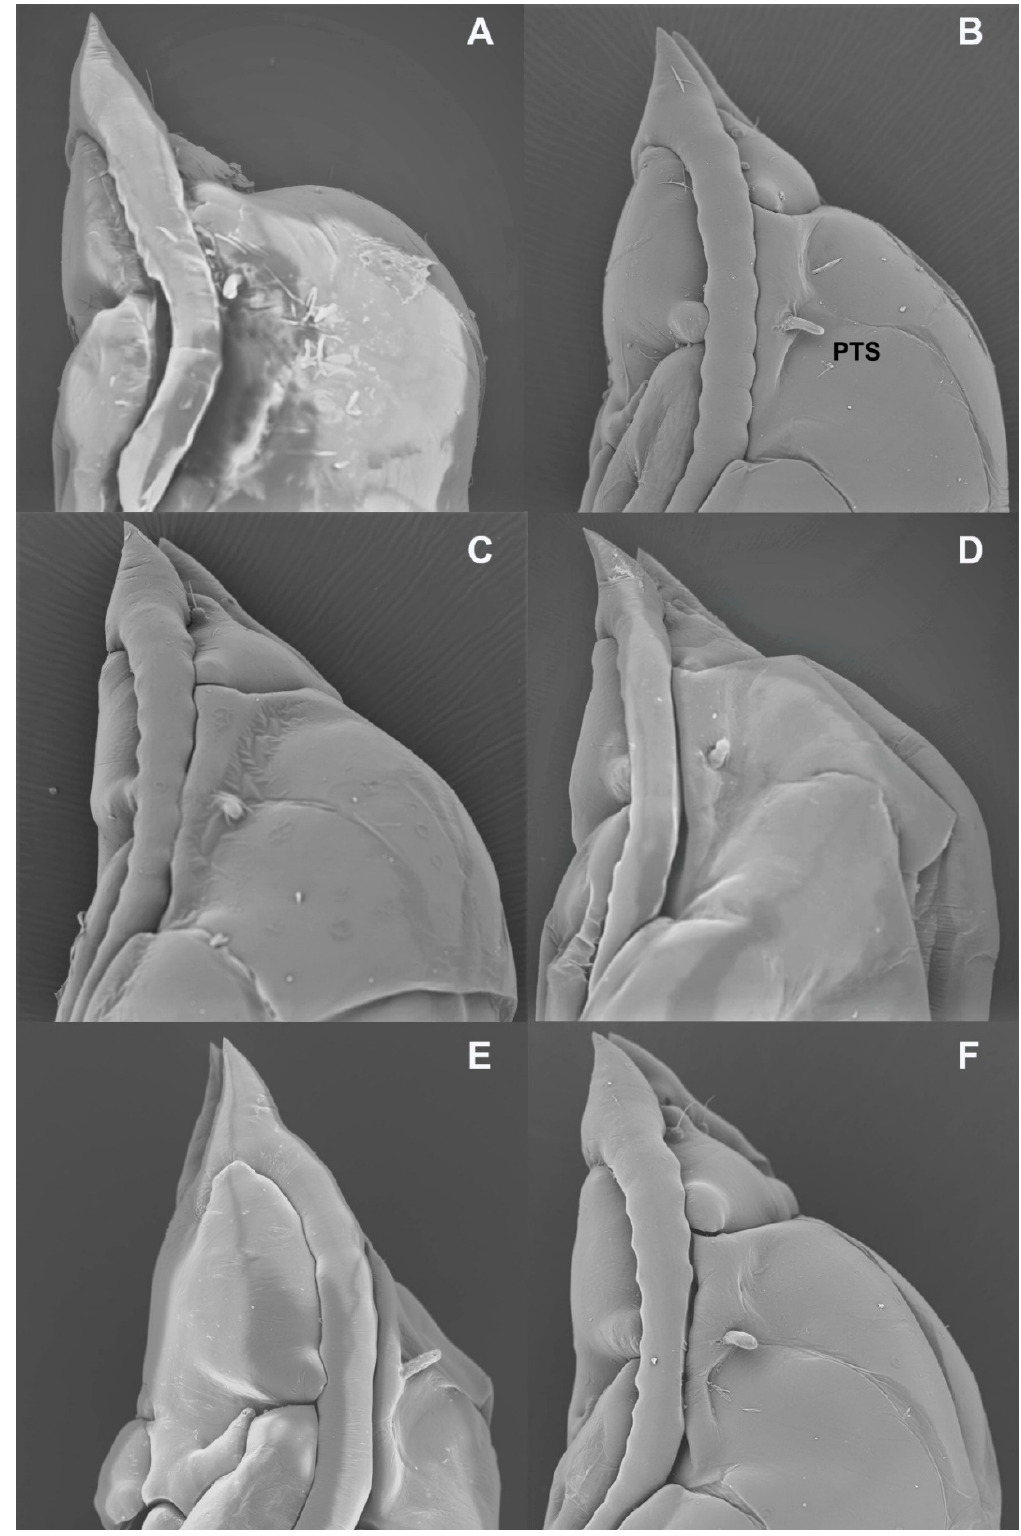
Figure 9. Ruschiola pupal heads, lateral. ( A ) R. attenuata . ( B ) R. cedarbergensis . ( C ) R. namaqua . ( D ) R. bubonis . ( E ) R. quagga . ( F ) R. leipoldtiae . PTS: prothoracic spiracle.